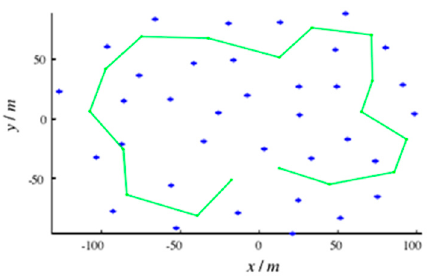
Figure 7. Simulation map.